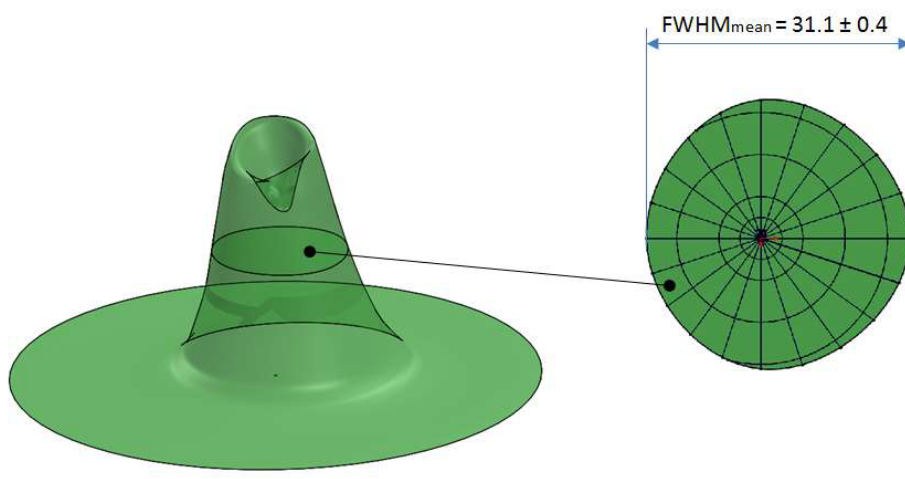
Figure 12. 3-D mapping of SQM 5143 angular response ( left ) and average FWHM ( right